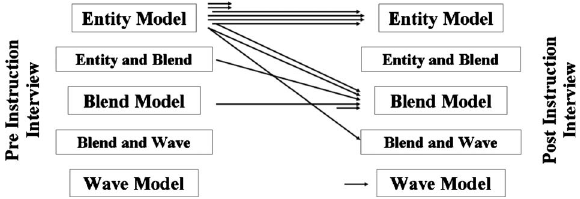
FIG. 2. The change in model states due